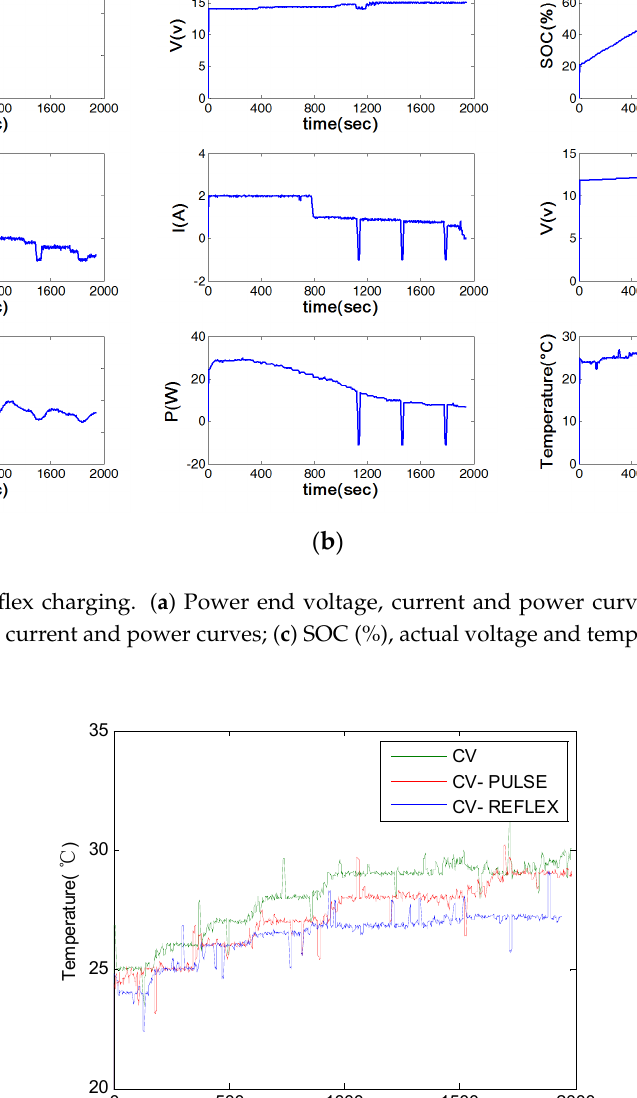
Figure 9. Schematic diagram of battery operation.